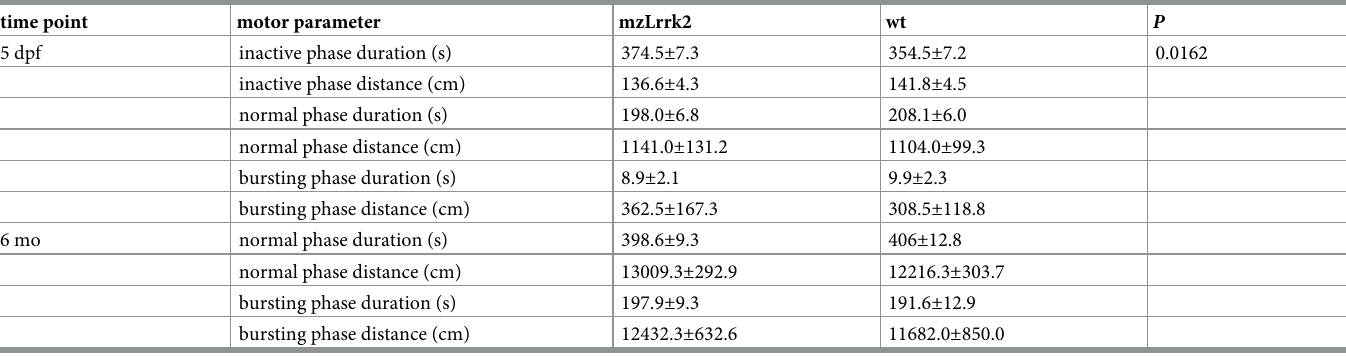
Table 2. Analysis of spontaneous swimming